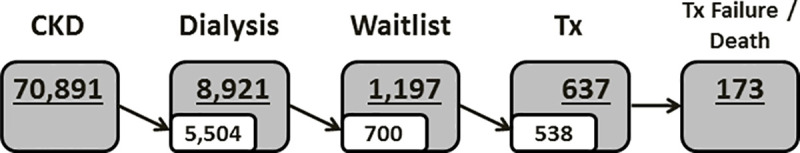
Number of patients in the respective subpopulations used for the analysis.